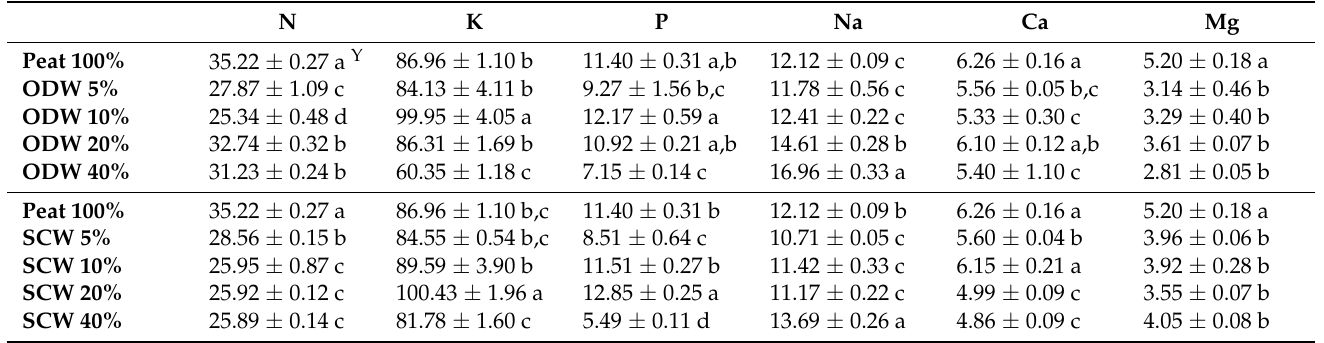
Table 5. Impact of growing media (peat, Origanum dubium waste—ODW, Sideritis cypria waste—SCW) on mineral element content (mg/g dry weight) of purslane